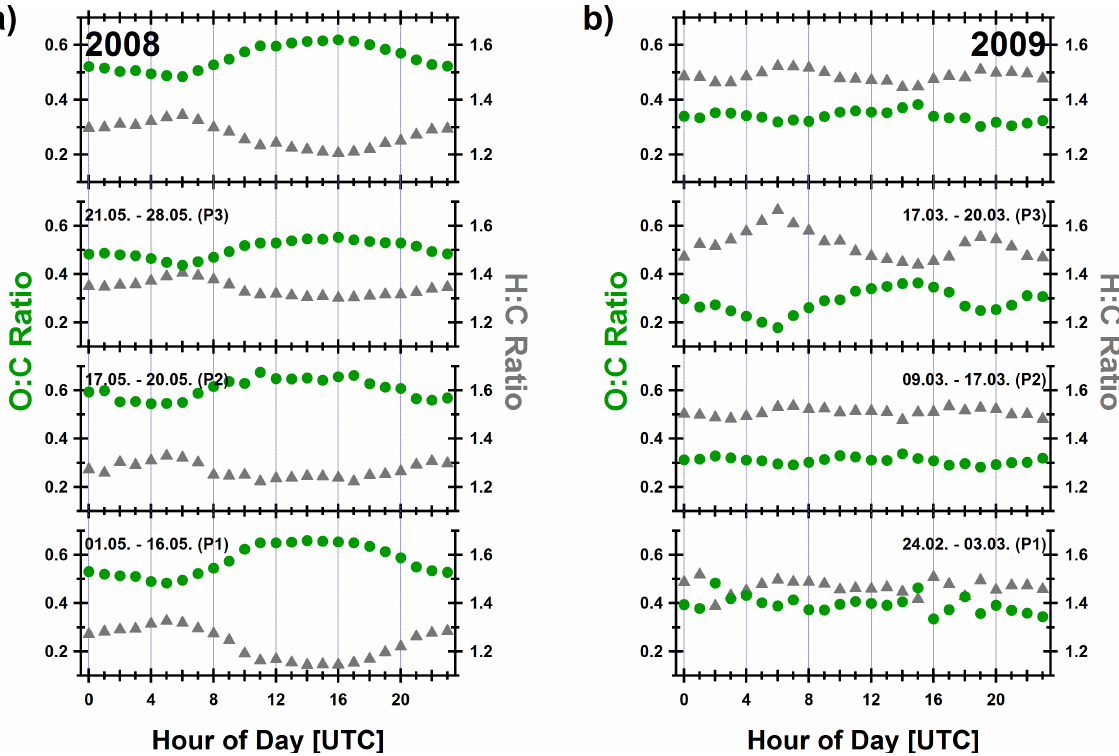
Fig. 11. Diurnal cycles of the O:C ratio (green dots, left axes) and H:C ratios (gray triangles, right axes) in May 2008 (a) and March 2009 (b) , respectively. The top panel in each graph shows the diurnal average for the entire measurement period and the three panels below show the average diurnal cycle for three specific time